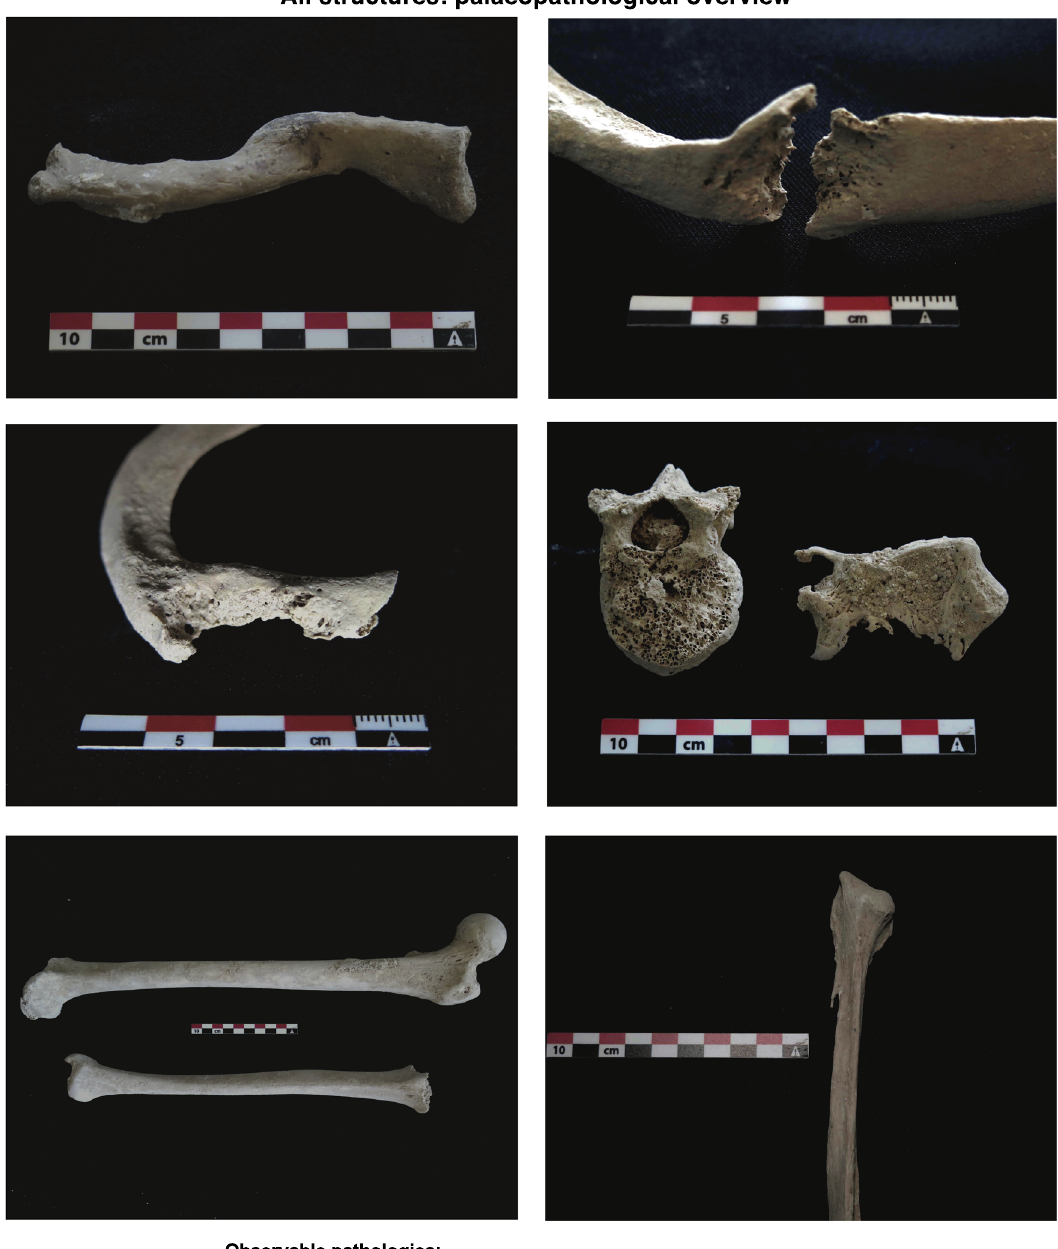
Figure 7: All structures: palaeopathological overview. Photographs by Hofstetter ( 2016 )